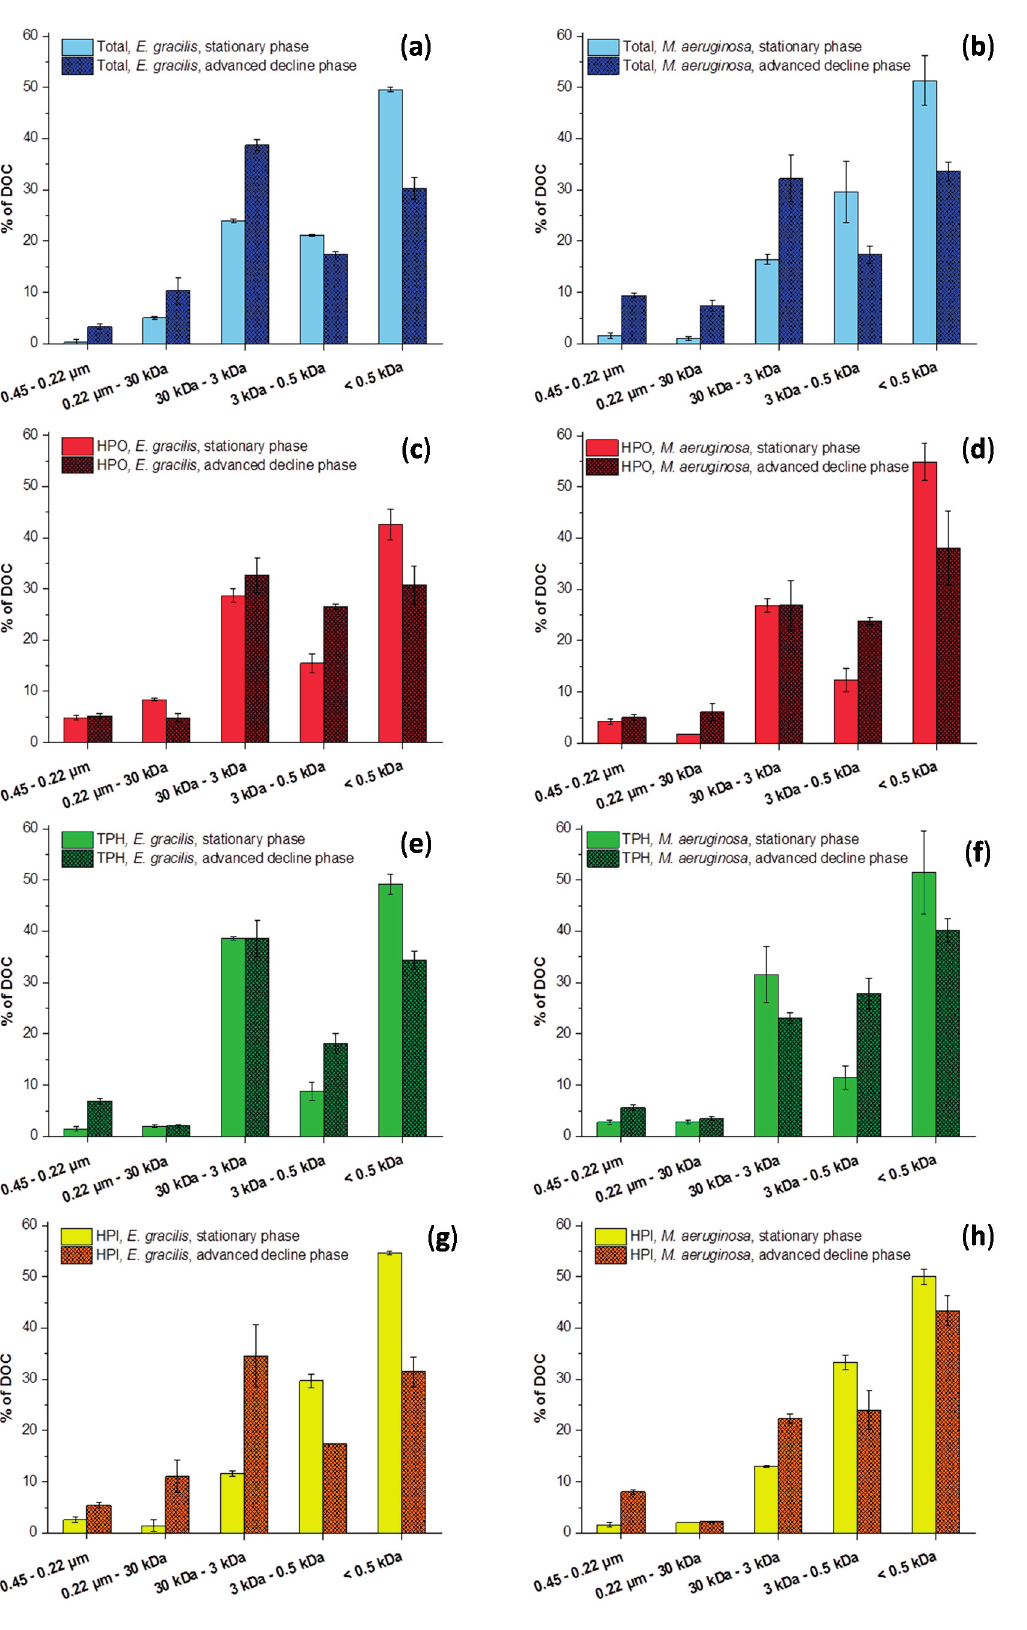
Figure 2. Comparison of size fractionation of dissolved organic matter: Evolution between the stationary and advanced decline phases: ( a , b ) are total samples from E. gracilis and M. aeruginosa ; ( c , e , g ) are, respectively, HPO, TPH and HPI fractions of AOM produced by E. gracilis and ( d , f , h ) are, respectively, HPO, TPH and HPI fractions from M. aeruginosa